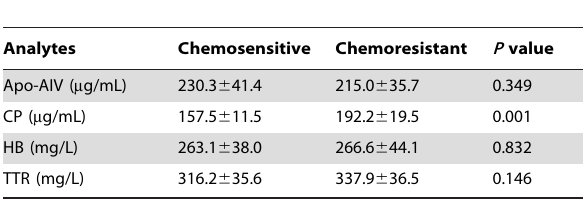
Table 3. Concentrations of proteins in ascites of intrinsically chemoresistant and chemosensitive